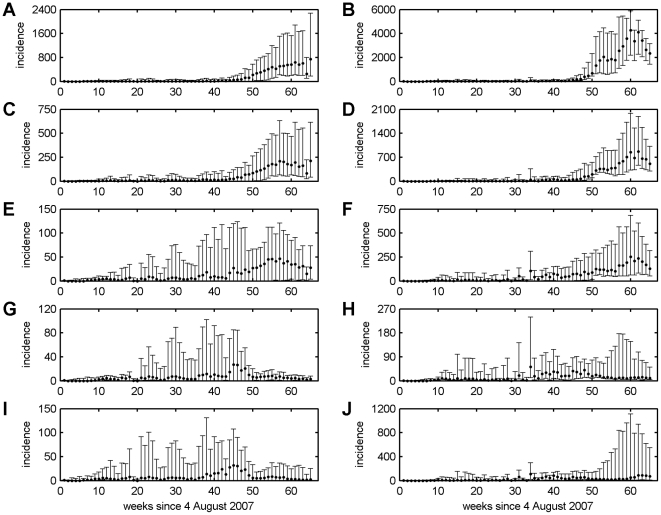
Predicted time-course of BTV-8 epidemics in GB under different vaccination and temperature scenarios.Results presented are for: (A, B) no vaccination; vaccination with (C, D) 50% uptake; (E, F) 80% uptake; (G, H) 95% uptake; and (I, J) variable levels of uptake (95% in the 2007 protection zone, 75% in the 2007 surveillance zone and 50% elsewhere). Simulations are based on (A, C, E, G, I) 2007 or (B, D, F, H, J) 2006 temperatures, assuming the best-fit Gaussian kernel to the north European data, a time to full protection in cattle of 60 dpv and vaccine efficacy of 100%. Each figure shows the median (circles) and 10th and 90th percentiles (error bars) for the incidence of BTV (number of new clinical holdings per week).